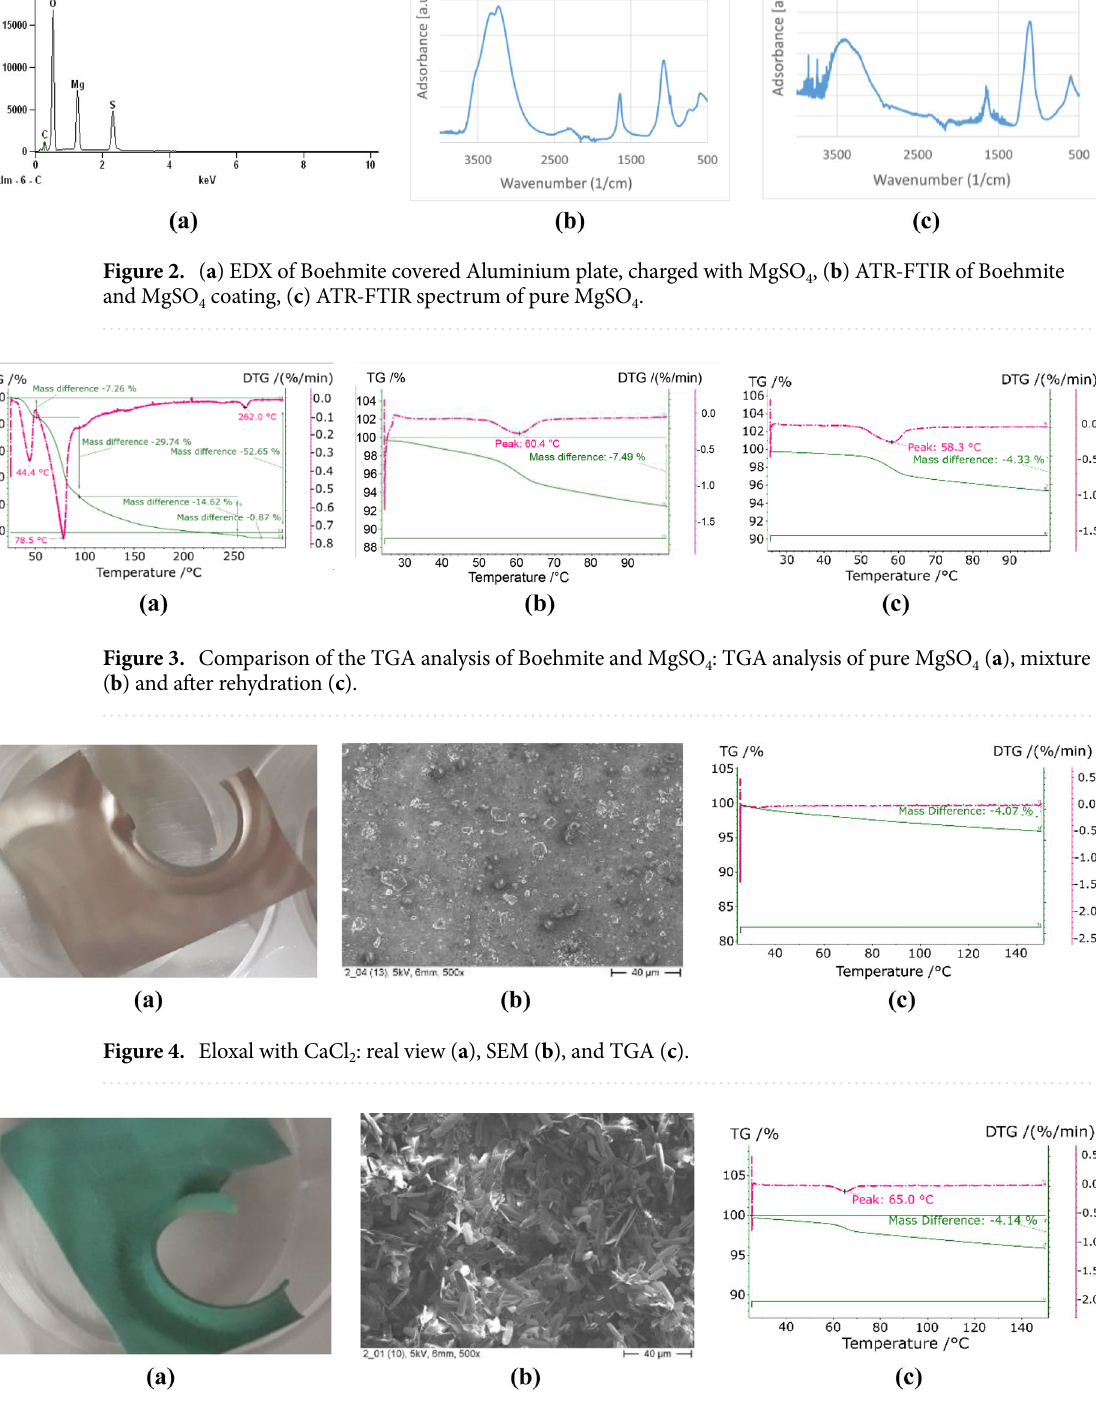
Figure 5. Eloxal with CuSO 4 : real view ( a ), SEM ( b ), and TGA ( c